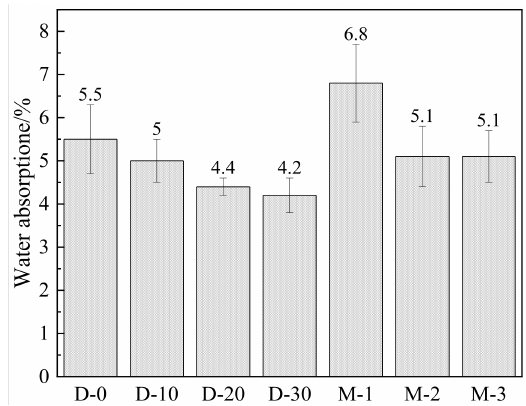
Figure 6. Water absorption in mortars.